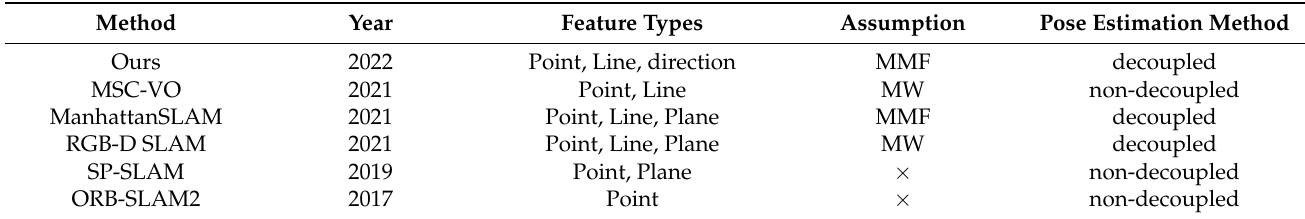
Table 1. Comparison of the proposed method with other works in the literature.